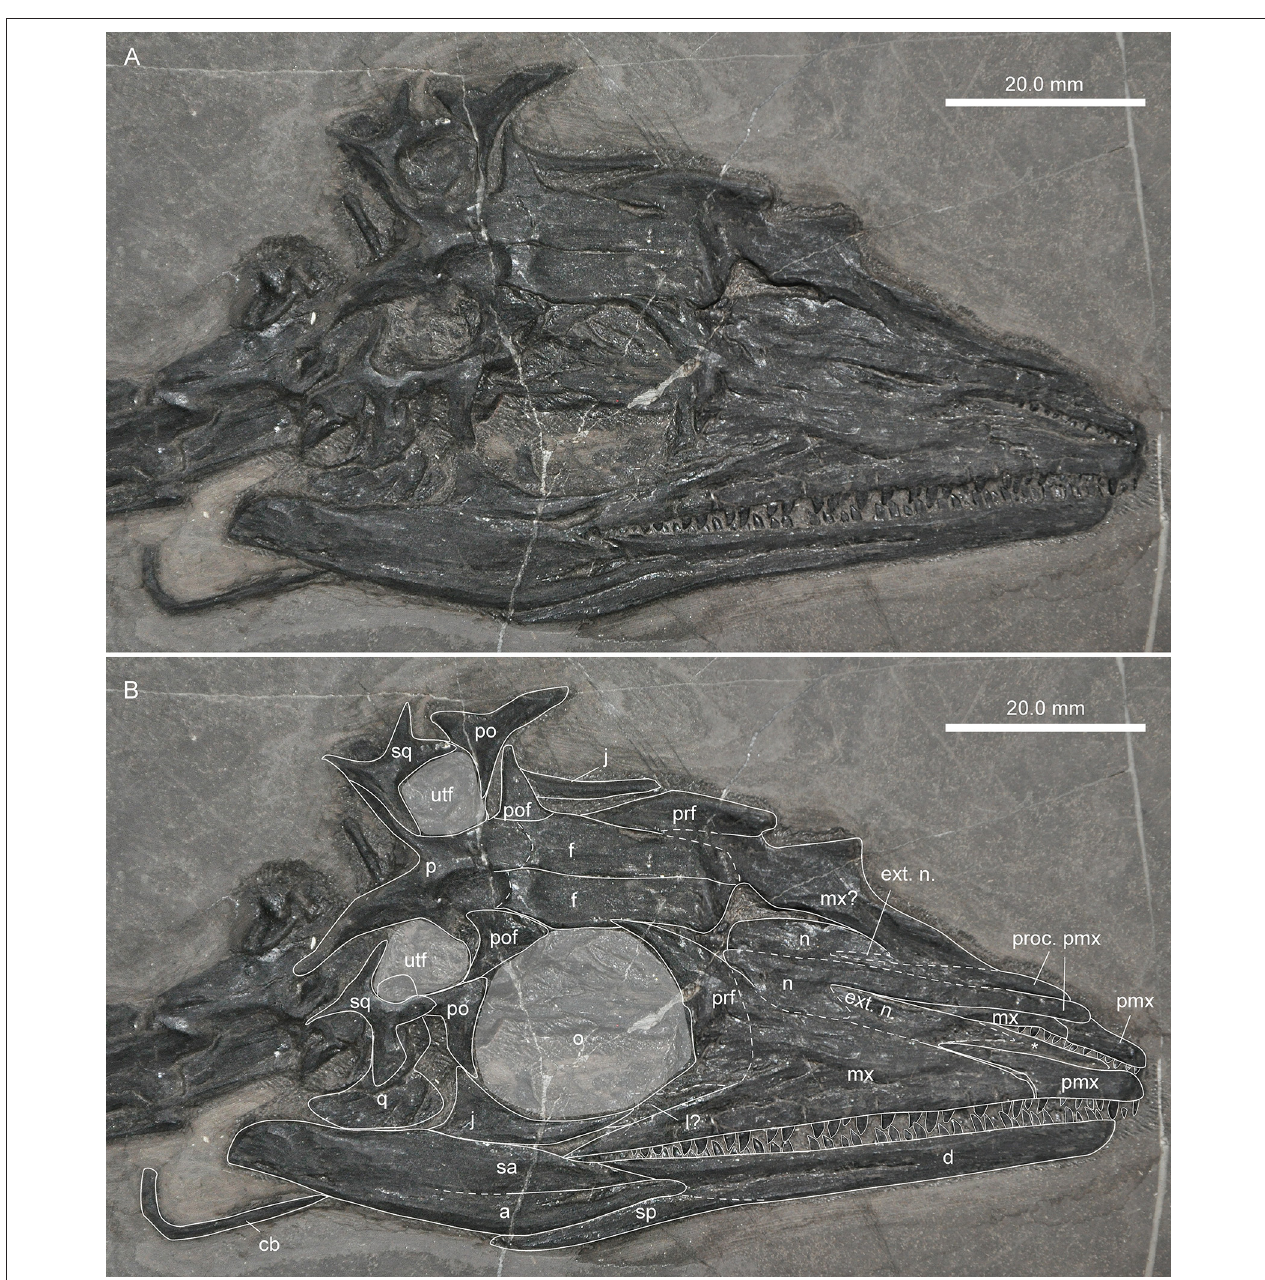
FIGURE 9 | Skull of specimen GMPKU-P-3001 of Macrocnemus fuyuanensis . (A) Photograph; (B) interpretative drawing superimposed. Note that the element indicated by an asterisk (*) could either be part of an exposed palate or, similarly likely, it could represent the median process of the premaxilla, which is otherwise not